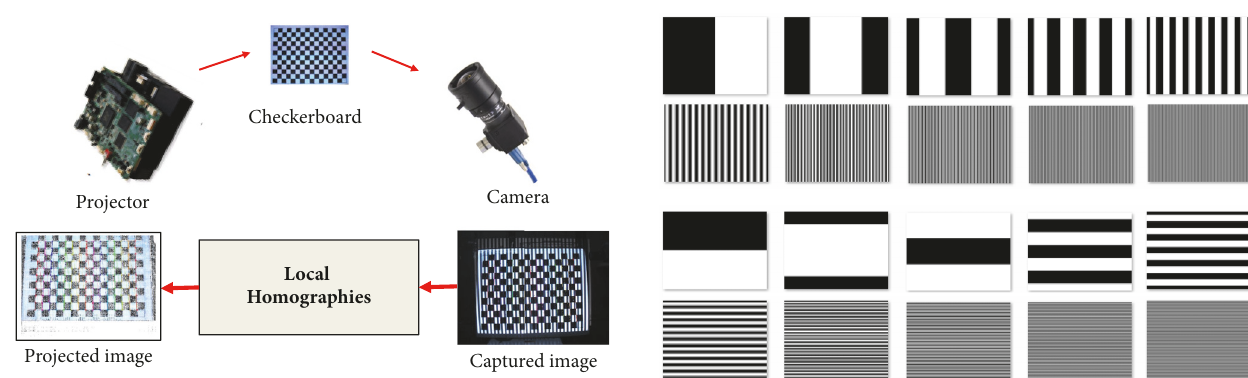
Figure 4: Thegray-code patterns for the RGB-D cameraused by the structure light technique [1].